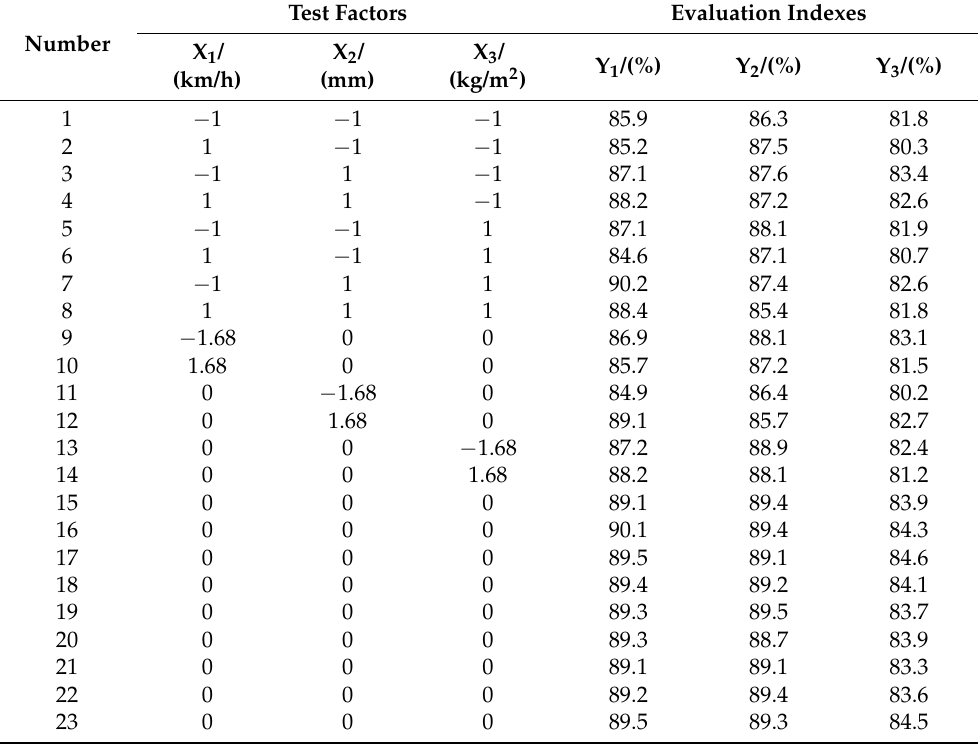
Table 6. Test scheme and results.